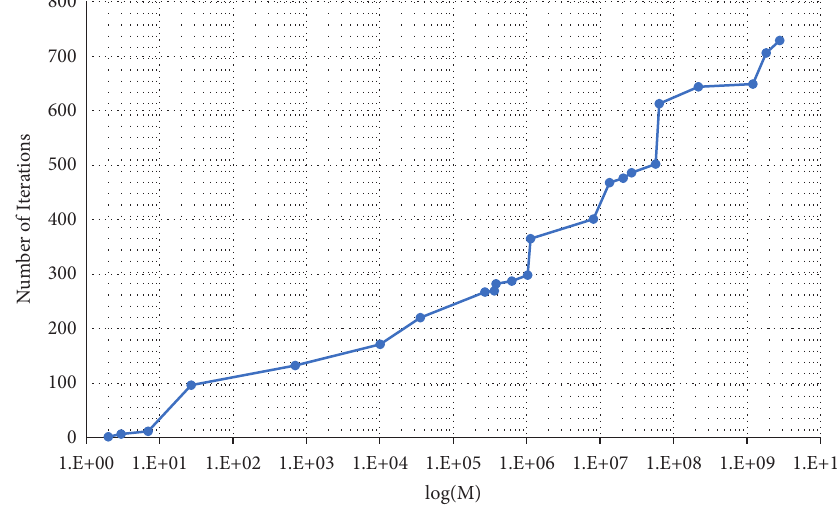
Figure 4: Logarithm of starting integer vs. number of iterations required for the Collatz